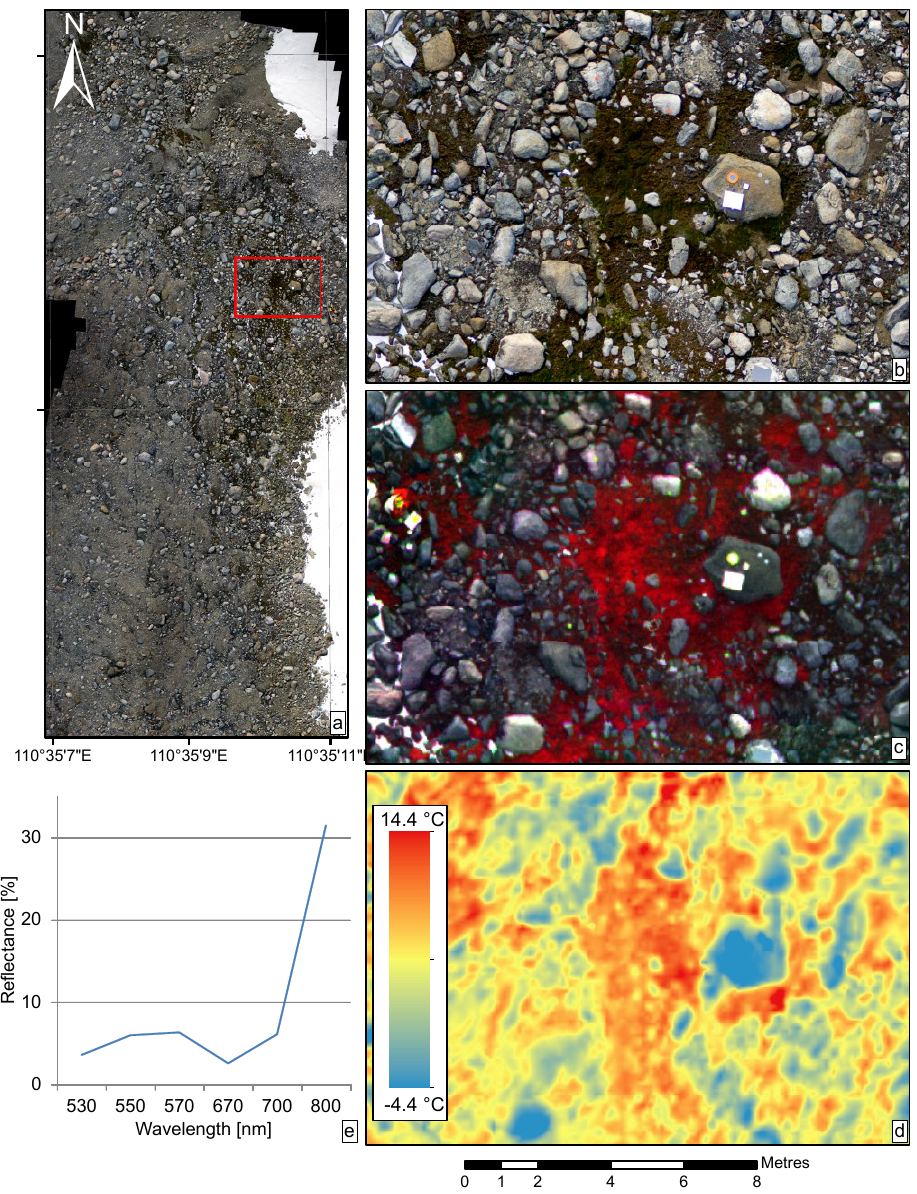
Figure 4. Robinson Ridge study site: ( a ) visible mosaic of entire area, ( b ) RGB image subset, ( c ) multispectral image subset, ( d ) thermal infrared image subset, and ( e ) typical multi-spectral reflectance function of a healthy Antarctic moss turf.